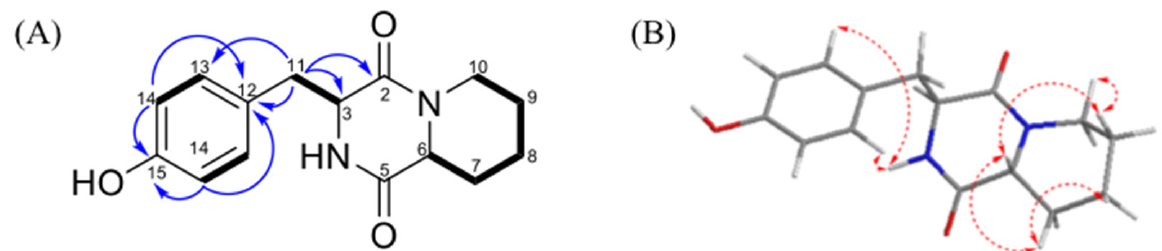
Figure 3. ( A ) The COSY and HMBC of 1 . ( B ) The NOESY correlations of 1 .